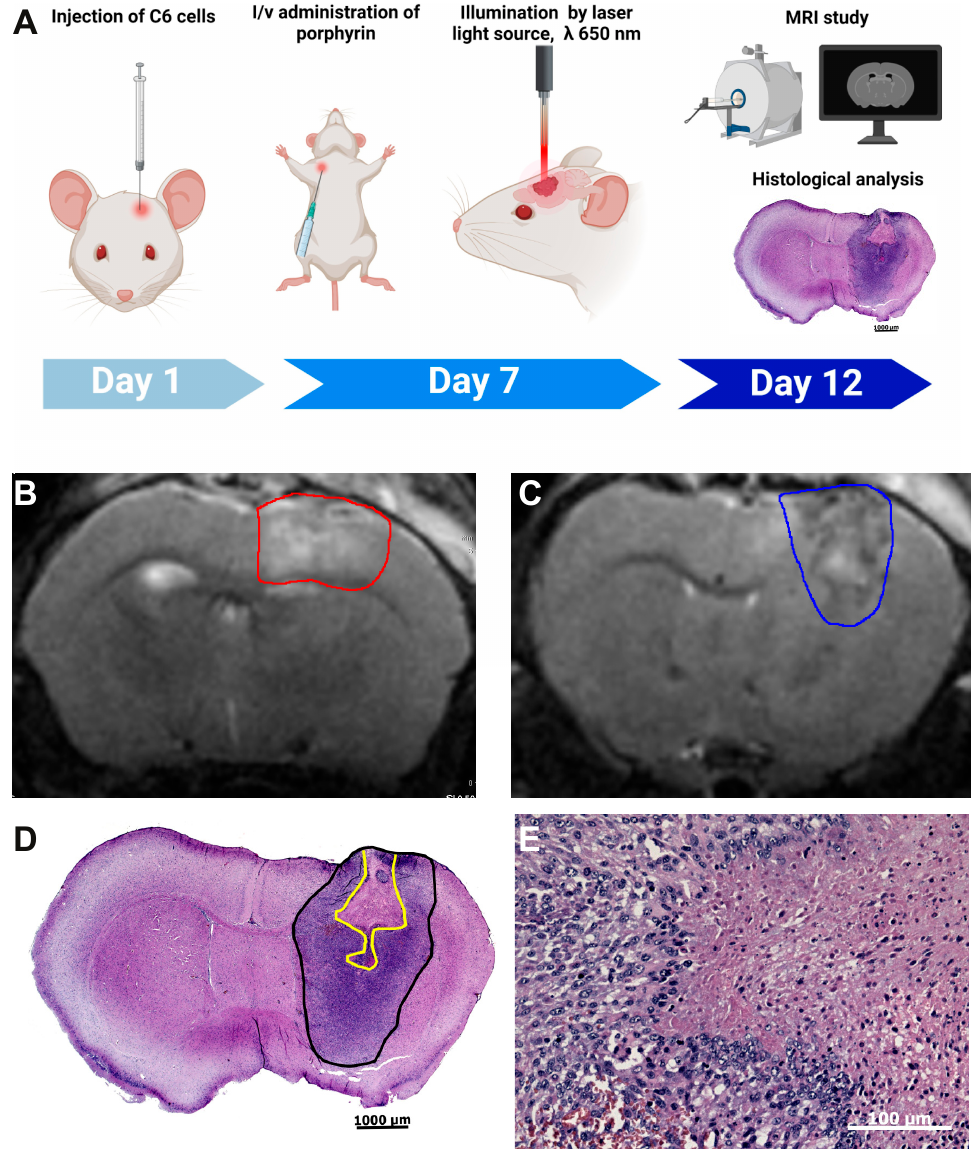
Figure 4. PDT using ETPA in a mouse model of glioblastoma: ( A ) scheme of the experiment; ( B , C ) representative T2-weighted MR images from coronal brain sections (0.5 mm thick) obtained 5 days after PDT. The area outlined with a red line refers to hyperintensities regions (edema, B ). The area outlined with a blue line refers to PDT-induced glioma necrosis ( C ); ( D ) a representative histological section, stained with eosin–hematoxylin, demonstrates the tumor boundaries (outlined in black) and the presence of necrotic loci in the area of laser illumination (outlined in yellow); ( E ) enlarged area showing the boundaries of necrotic and intact tumor tissues. Images shown are representative of 3